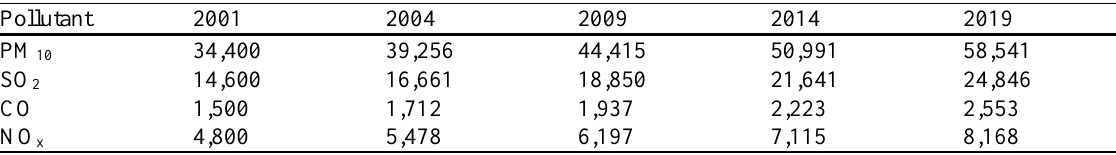
Table 3. Future damage costs (k Rial/ton)